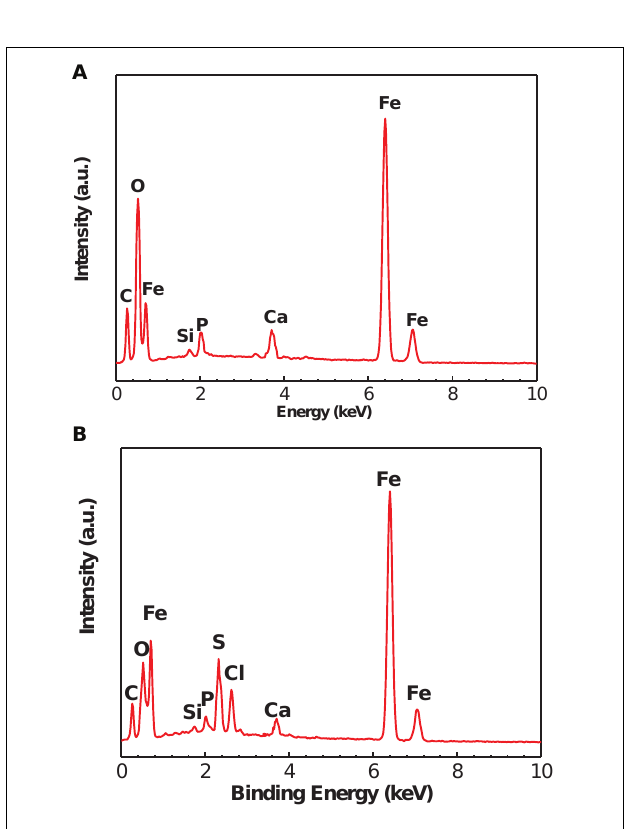
FIGURE 3 | Energy dispersive x-ray spectrum analysis of corrosion product film and SRB biofilm on specimens after 14-days of incubation in the absence (A) and presence (B) of SRB, respectively.